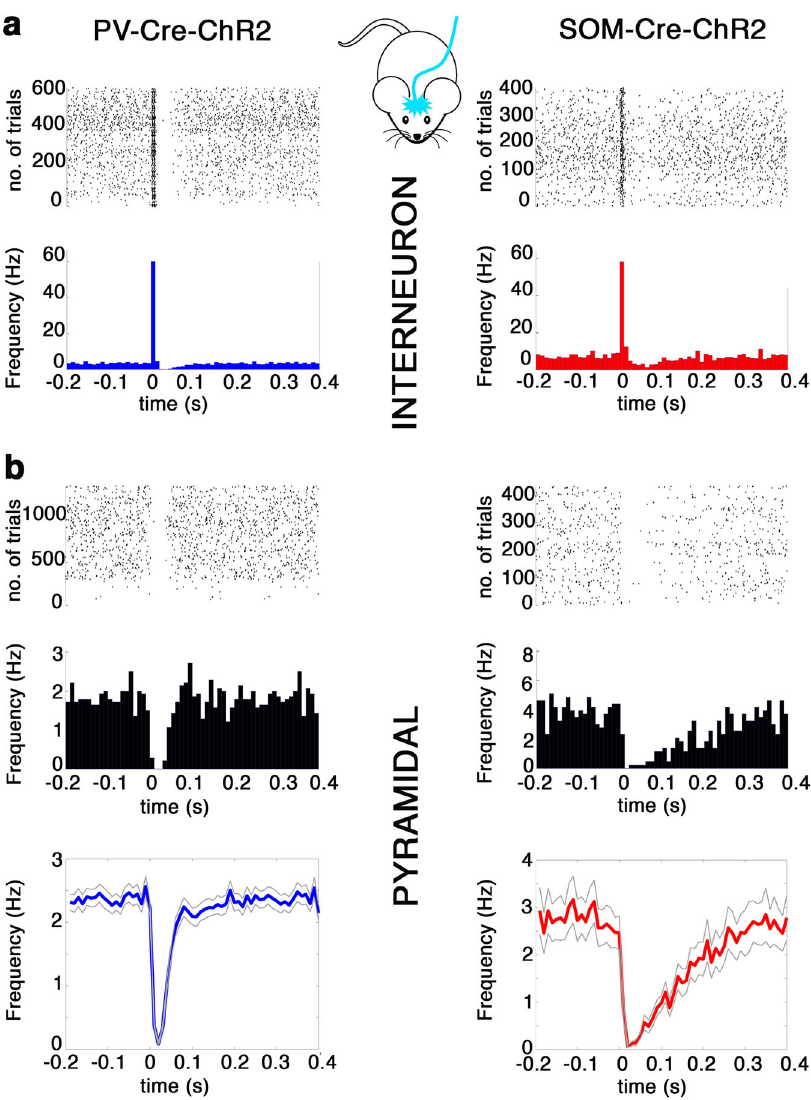
Fig. 3 Prolonged SOM + inhibition in the MEC in awake behaving mice. Optogenetic modulation of MEC networks in vivo in PV-Cre-ChR2 (left column) and SOM-Cre-ChR2 (right column) animals. a Representative spike raster (top) and peri-stimulus histogram (PSTH, bottom) of light-responsive putative PV + (left) and a SOM + (right) interneuron aligned to the 10 ms light onset (0 s). Middle: schematic representation of experimental set-up. b Raster plot (top) and PSTH (middle) of representative light-inhibited putative pyramidal cells in PV-Cre (right) and SOM-Cre (left) animals. Bottom: average (solid line) and standard error of the mean (gray) of all inhibited putative pyramidal cells in PV-Cre (left) and SOM-Cre (right) animals. Note the quick return of fi ring in PV-Cre-ChR2 animals and the elongated inhibition in SOM-Cre-ChR2 animals. All traces aligned to light onset (0